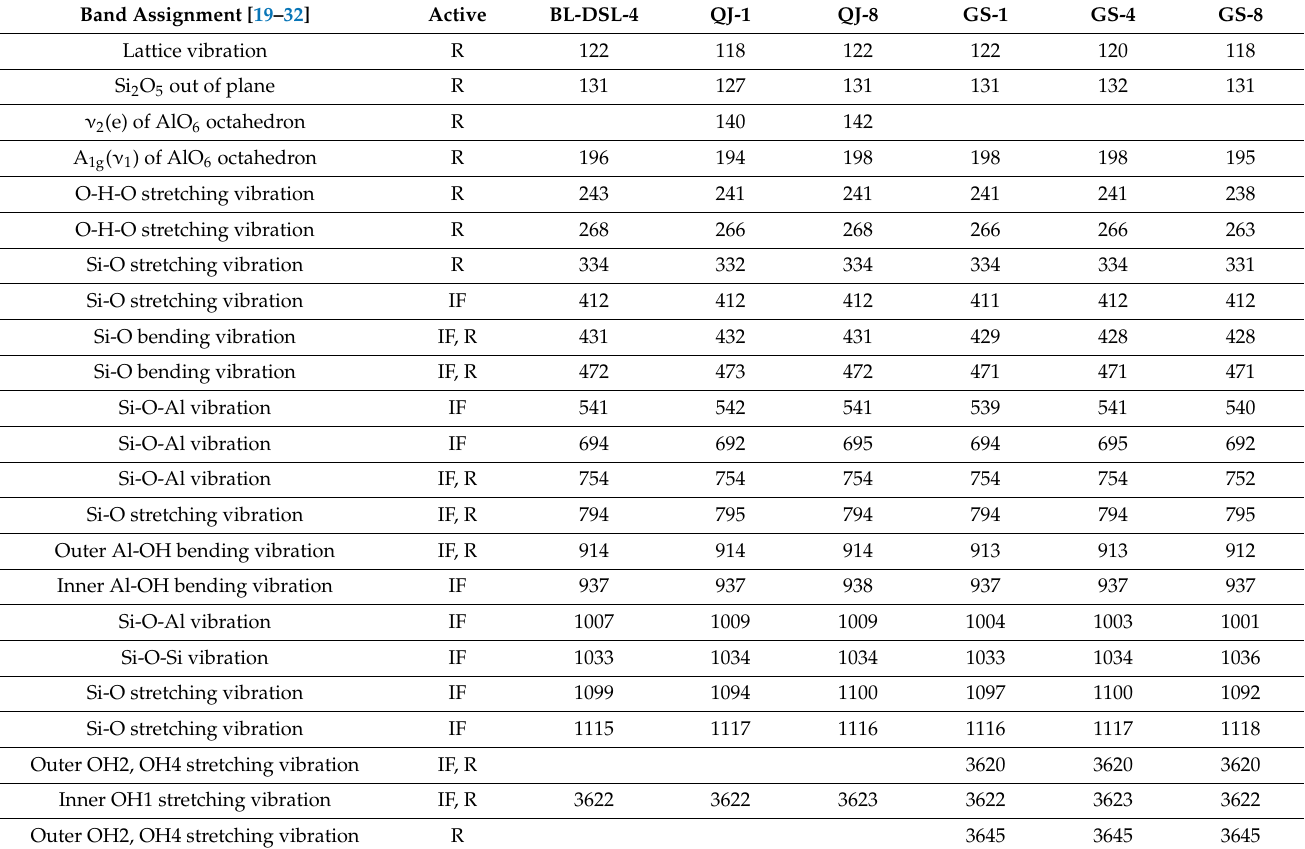
Figure 5. Raman spectral component analysis of the OH stretching region. Table 2. The MIR and Raman bands related to kaolinite mineral samples and their assignments (cm − 1 ).